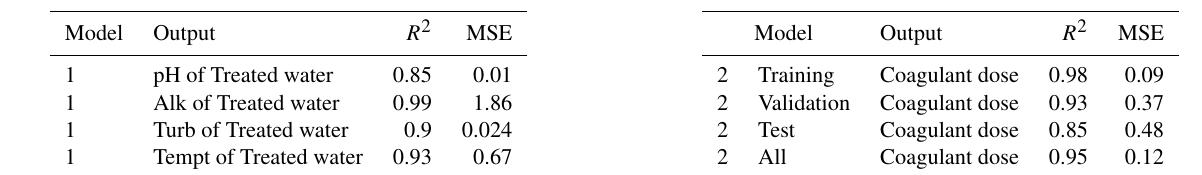
Table 3. The Results of the Neural Model No .1. Table 4. The Results of the ANN No.